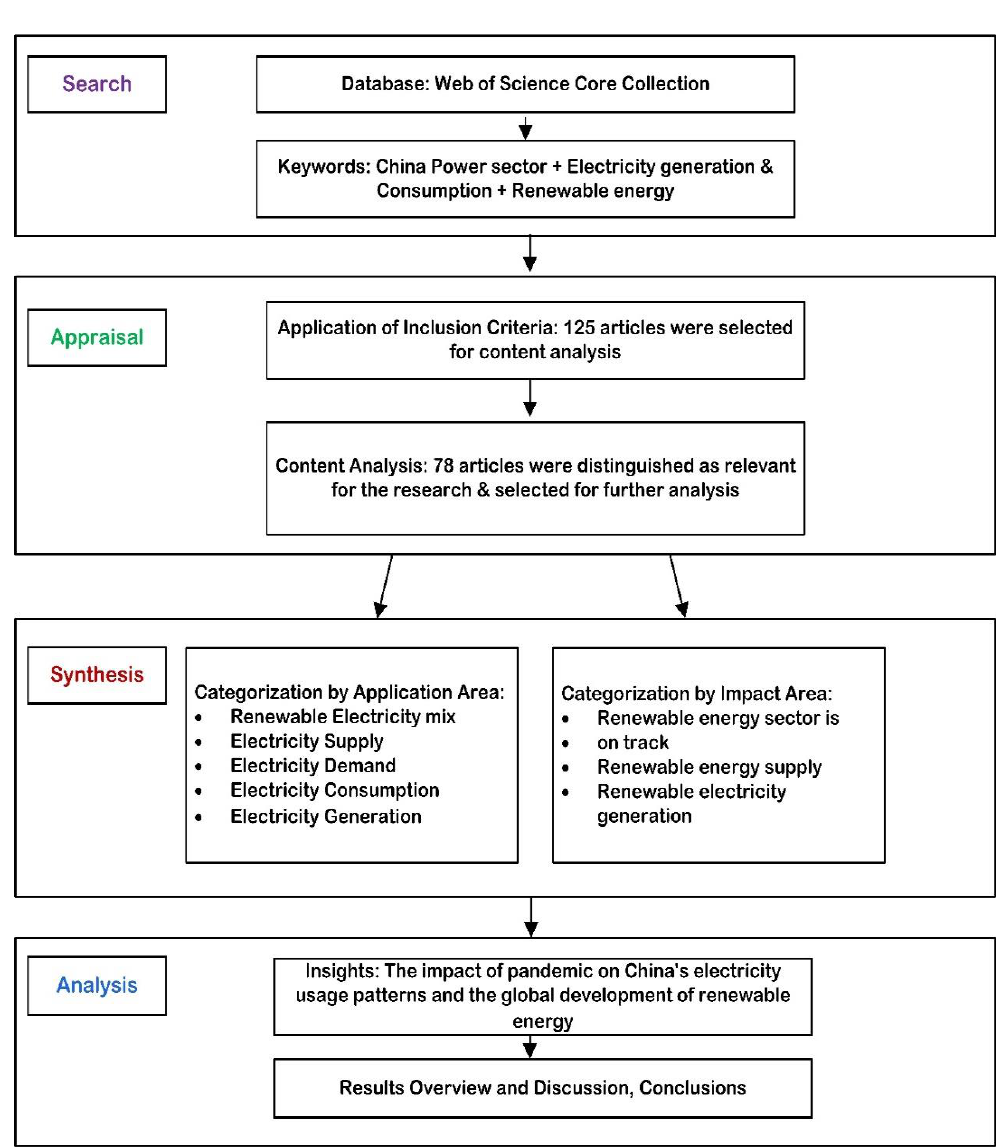
Figure 1. An overview of the methodology used in the study.